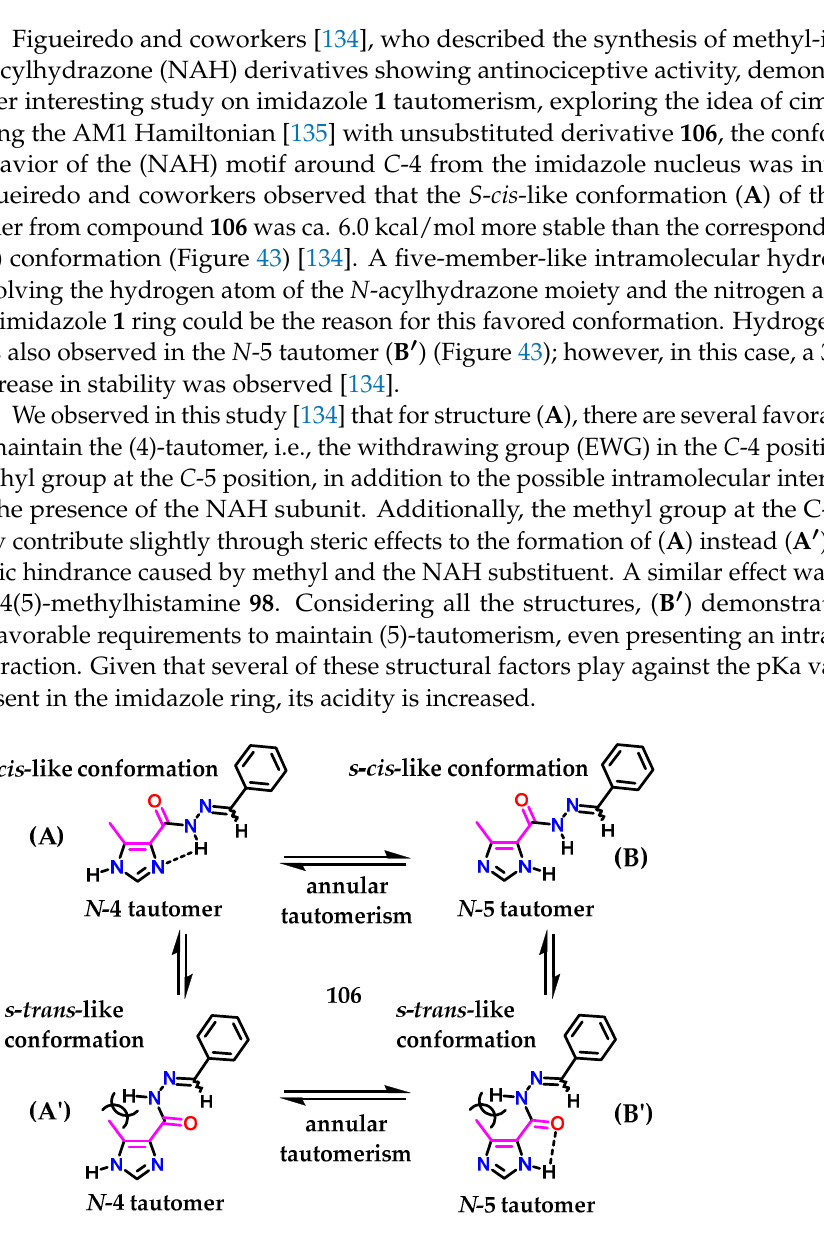
Figure 43. Ring isomerism and conformers of N -acylhydrazone derivative 90 .